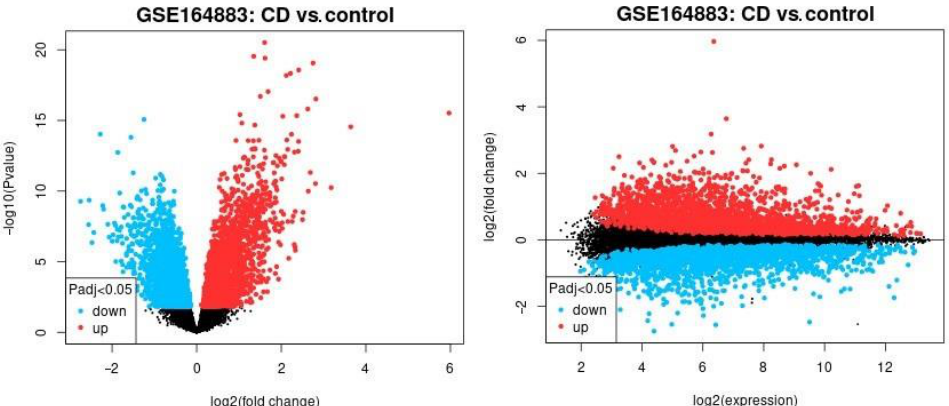
Figure 1. The differential gene expression between celiac disease and control cases. The gene expression of the groups of celiac disease and control samples were compared using GEO2R software. The up-regulated genes are highlighted in red, the down-regulated in blue, and the non–significant in black. Left, the volcano plot. Right, mean difference plot.